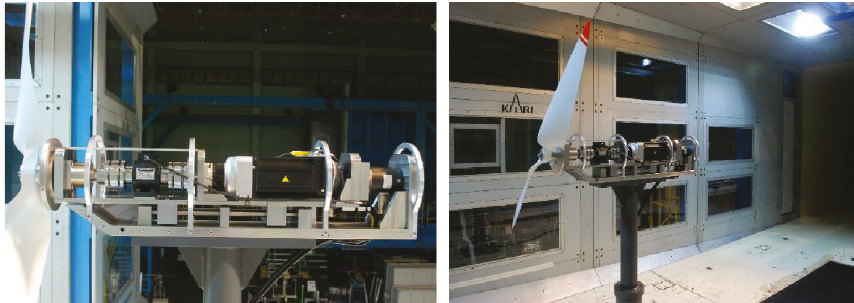
Figure 15: Installation of measurement